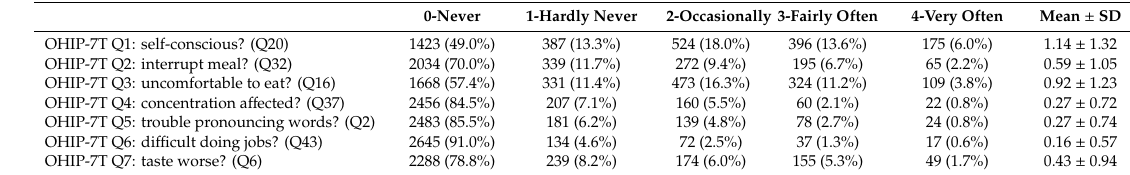
Table 2. Demographic distribution of the Taiwanese short-form of the Oral Health Impact Profile (OHIP-7T). 0-Never 1-Hardly Never OHIP-7T Q1: self-conscious? (Q20)